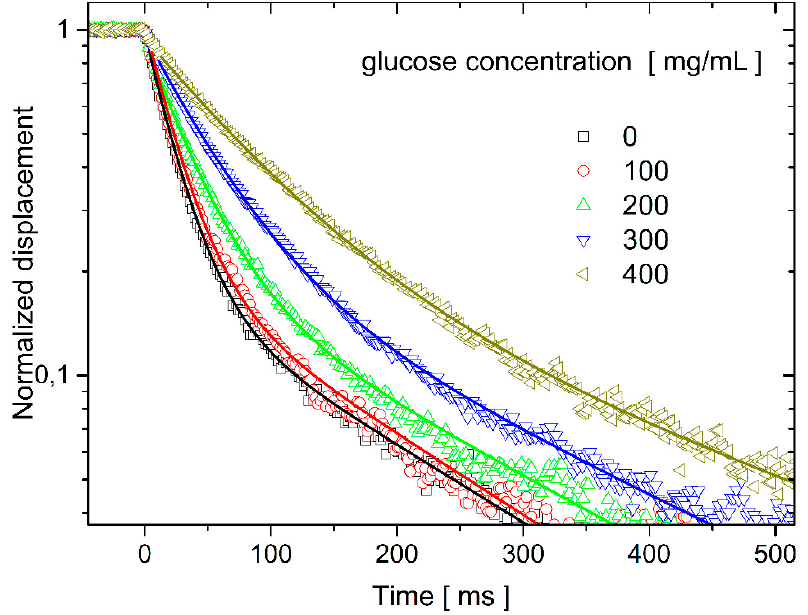
Figure 3. The experimental bending recovery curves of the cantilever nanowire system were meas- ured at different glucose concentrations. The data points were fitted by double-exponential time dependencies (solid lines). Table 1. Representative values of the mechanical model parameters (stiffnesses k 1,2 and the intrinsic damping coefficient δ ) and the corresponding material properties (elastic moduli E 1,2 , and the intrinsic viscosity η i ) are evaluated for pure water and dense glucose solution conditions. The equilibrium stiffness k eq is calculated as: 1/ k eq = 1/ k 1 + 1/ k 2 . The equilibrium elastic modulus E eq is obtain